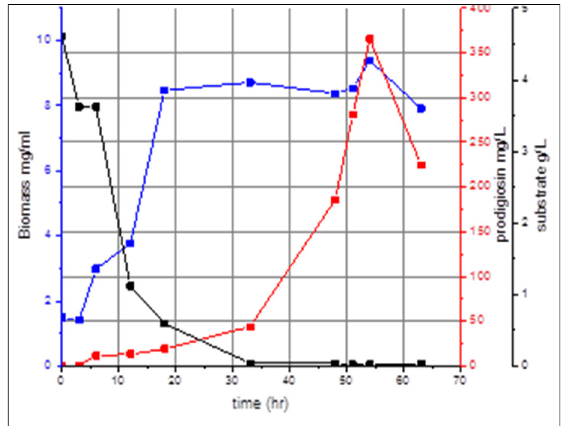
Fig. 9. Time course of cell growth ( ■ ), substrate consumption ( ■ ) and prodigiosin production ( ■ ) by S. marcescens in optimized medium in shaker incubator at 200 rpm and 30 °C.